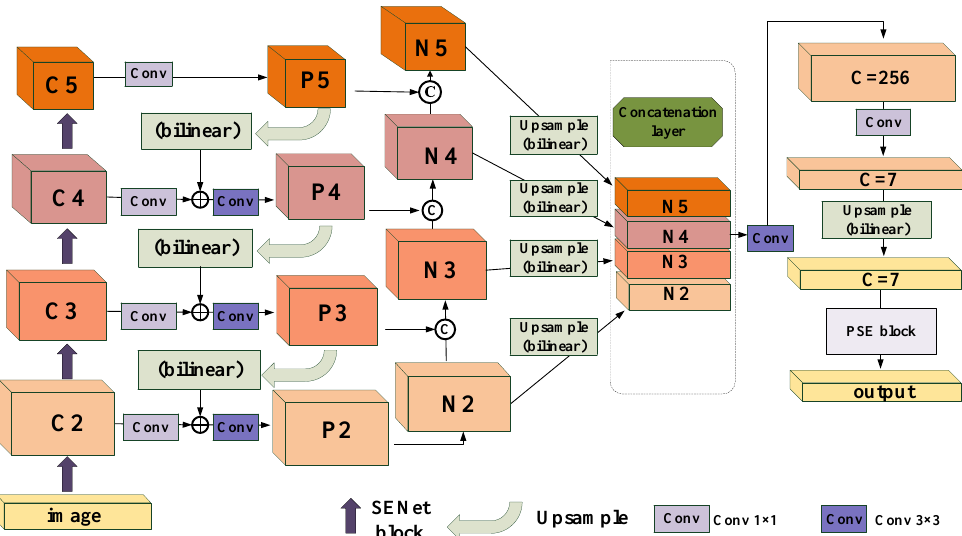
Figure 1. An illustration of our framework. It includes a basic structure with SE blocks; a backbone of feature pyramid networks; bottom-up path augmentation; the progressive scale expansion algorithm, which predicts text regions, kernels, and similarity vectors to describe the text instances. Note that we omit the channel dimensions of feature maps for